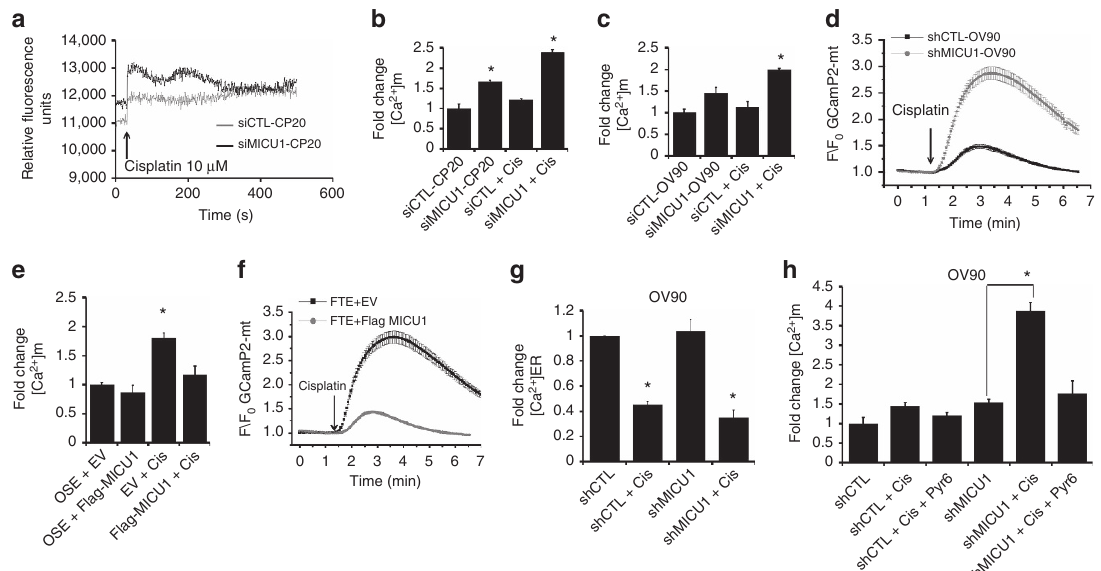
Figure 4 | MICU1-mediated Ca 2 þ buffering in OvCa cells evaluated using cisplatin. ( a ) CP20 cells loaded with the fluorescent dyes Rhod-2AM (5 m M), 10 m M cisplatin caused rapid increase in [Ca 2 þ ] m . ( b , c ) Silencing of MICU1 by siRNA increased [Ca 2 þ ] m responses to cisplatin in CP20 (B) or OV90 ( c ) cells loaded with Rhod-2AM (5 m M) and values are mean ± s.d. ( d ) Normalized GCaMP2-mt fluorescence in shRNA transfected (shCTL-OV90) or MICU1- specific shRNA transfected (shMICU1-OV90) cells stimulated with cisplatin (10 m M). The experiment was repeated three times (total no. of cells cell quantified: shCTL-OV90 n ¼ 158 and shMICU1-OV90 n ¼ 128). ( e ) Changes in [Ca 2 þ ] m in OSE cells expressing Flag-MICU1 upon 10 m M cisplatin treatment as compared to empty vector (EV) transfected cells and values are mean ± s.d. ( f ) Normalized GCaMP2-mt fluorescence in FTE188 cells transfected with empty vector (FTE þ EV) or Flag-MICU1 (FTE þ Flag-MICU1) cells stimulated with cisplatin (10 m M). The experiment was repeated three times (total no. of cells quantified: FTE þ EV n ¼ 135 and FTE þ Flag MICU1 n ¼ 433). ( g ) Cisplatin causes similar release of [Ca 2 þ ] ER in presence or absence of MICU1 as determined in OV90 cells loaded with [Ca 2 þ ] ER indicator dye Fluo-5N (5 m M) and values are mean ± s.d. ( h ) Disruption of [Ca 2 þ ] ER